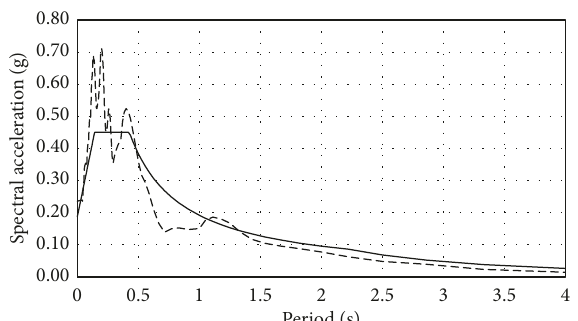
Figure 6: Comparison between the elastic response spectrum (NTC 2018) and the spectrum obtained by the record 147ya of Friuli.